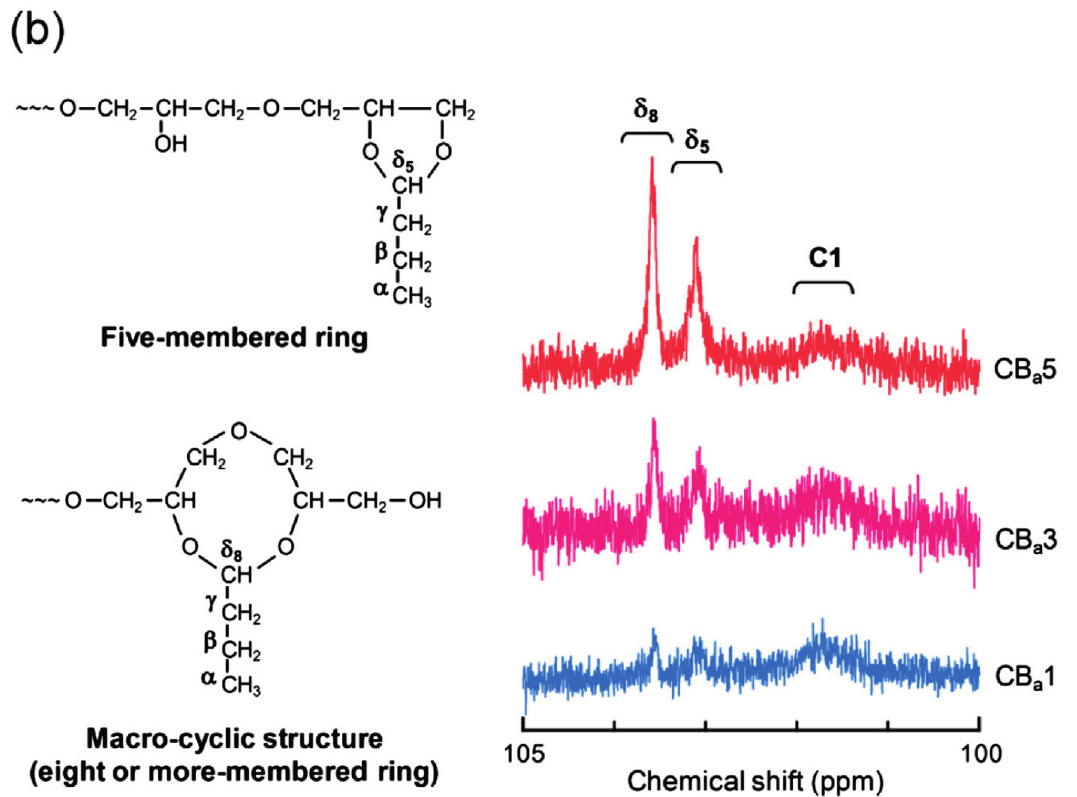
Figure 9. ( a ) Derivatization reactions and 13 C-NMR spectra of cellulose butyral products in pyridine- d 5 showing the butyral carbon assignment; ( b ) enlarged 13 C-NMR spectra between 100 and 105 ppm and peak assignments. The DHPC precursor comprised 81.1 wt % dihydroxypropyl unit. Butyral molar substitutions of the products are 0.20, 0.94, and 3.60 for CB a 1, CB a 3, and CB a 5, respectively. Reprinted with permission from ref. [29]. Copyright 2014 Elsevier